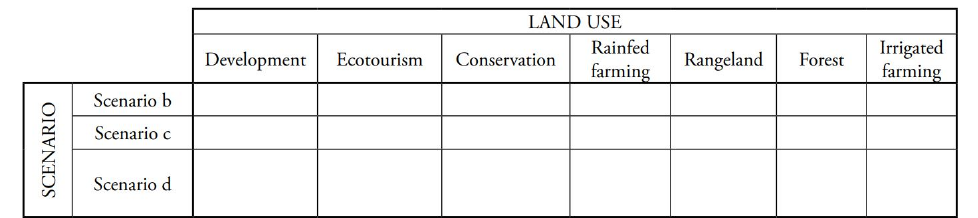
Table 2: The questionnaire sample distributed among